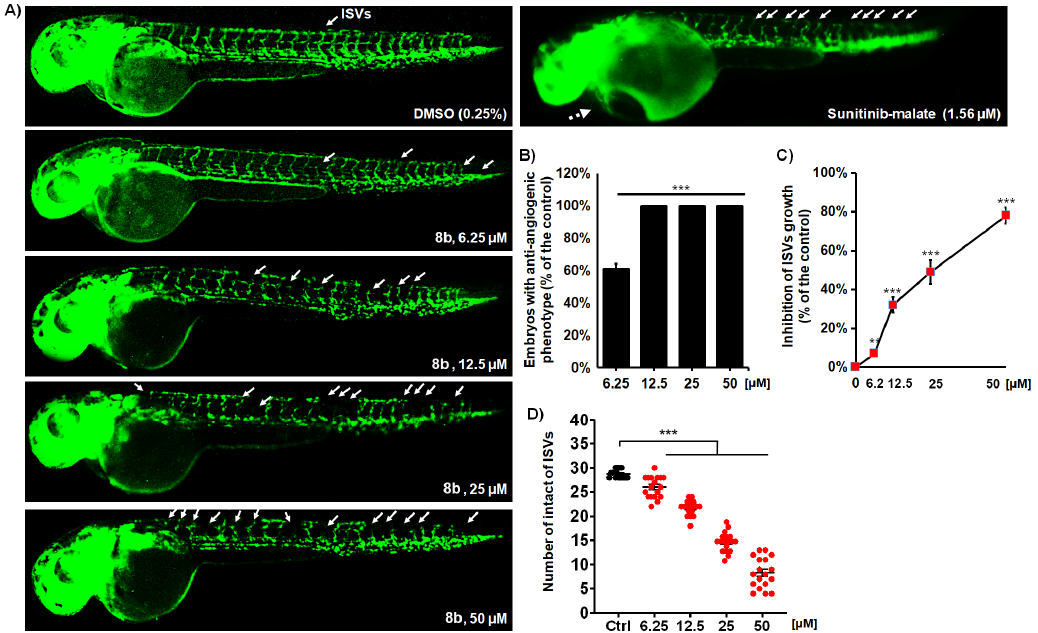
Figure 9. Compound 8b effectively inhibits angiogenesis in Tg(fli1:EGFP) zebrafish embryos with fluorescently labeled endothelial cells. Embryos were exposed to the four doses of 8b and assessed the inhibition of ISV vasculature at 48 hpf ( A ). Treatment with 8b increased the number of embryos with the anti-angiogenic phenotype ( B ), decreased the number of normally developed ISVs ( C ), and reduced the ISV length ( D ) in the dose-dependent manner. Sunitinib-malate (Suten), a clinically approved anti-angiogenic drug, was used as a positive control. While the Suten caused life-threating cardiotoxicity at the effective dose of 1.56 µM, 8b inhibited angiogenesis without any toxic response in the treated embryos. Representative images of embryos are shown. Data are normalized in relation to the control group ( B , C ). Significance in the analyzed parameters between 8b -treated embryos and control (DMSO-treated) embryos is indicated with asterisks (** p < 0.01; *** p < 0.001).